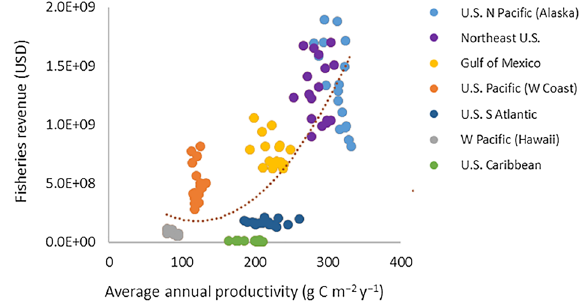
Figure 2. Relationship between average annual productivity (g C m −2 year −1 ) and total fisheries revenue (USD) throughout all major US regions. Years 1998–2014. Regression (y = 32187x 2 − 8 × 10 6 x + 7 × 10 8 ; r 2 = 0.600; p <